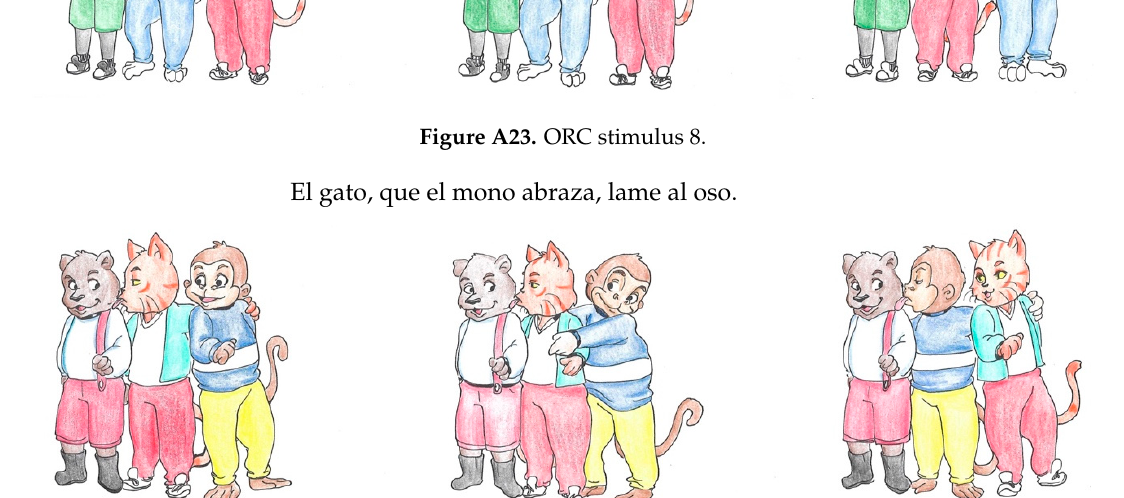
Figure A25. ORC stimulus 10. Appendix A.4. Filler Stimuli El perro le promete al oso sentarse, y lo hace.